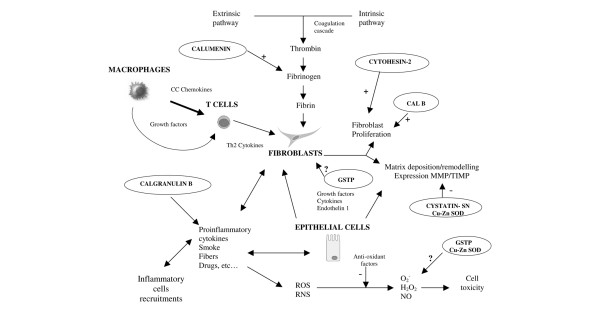
Hypothetical role of some disregulated BALf proteins in mechanisms driving SSc-related lung fibrosis. Inflammation is thought to be the main mechanism driving lung fibrosis in scleroderma patients. In this complex inflammatory process several pathways are involved, including the activation of T cells and epithelial cells, the secretion of pro-inflammatory cytokines and growth factors, and fibroblast proliferation. Furthermore, products from the coagulation cascade and oxidative stress may contribute to fibrogenesis. The upregulation of calgranulin B (Cal B), cytohesin-2 and calumenin might favor inflammation and fibrogenesis, whereas the downmodulation of the protective factors glutathione S-transferase P (GSTP), Cu–Zn superoxide dismutase (SOD) and cystatin SN may amplify tissue injury and inflammation. MMP, matrix metalloproteinases; TIMP, tissue inhibitor of matrix metalloproteinases; ROS, reactive oxygen species; RNS, reactive nitrogen species; O2-, superoxide; H2O2, hydrogen peroxide; NO, nitric oxide; SScFib+, systemic sclerosis patients with lung fibrosis; SScFib-, systemic sclerosis patients without lung fibrosis.